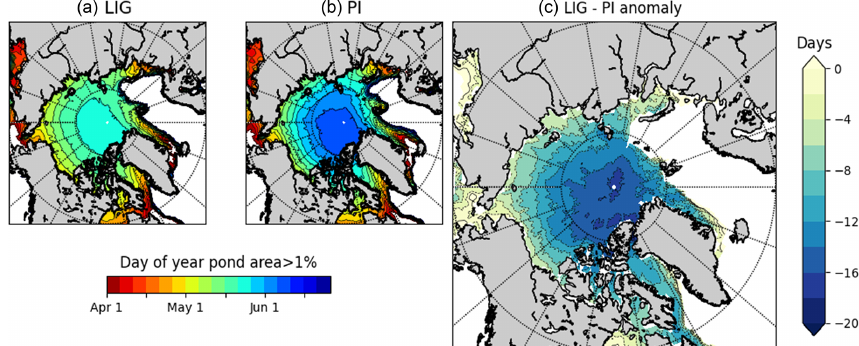
Figure 8. First day of melt pond formation as proxy for melt onset. The mean day of the year the grid-cell melt pond fraction grew above 0.01 for (a) LIG, (b) PI, and (c) the LIG–PI anomaly. All figures show the 200-year mean from daily model output. Only grid cells still ice-covered when melt ponds began to form are shown.